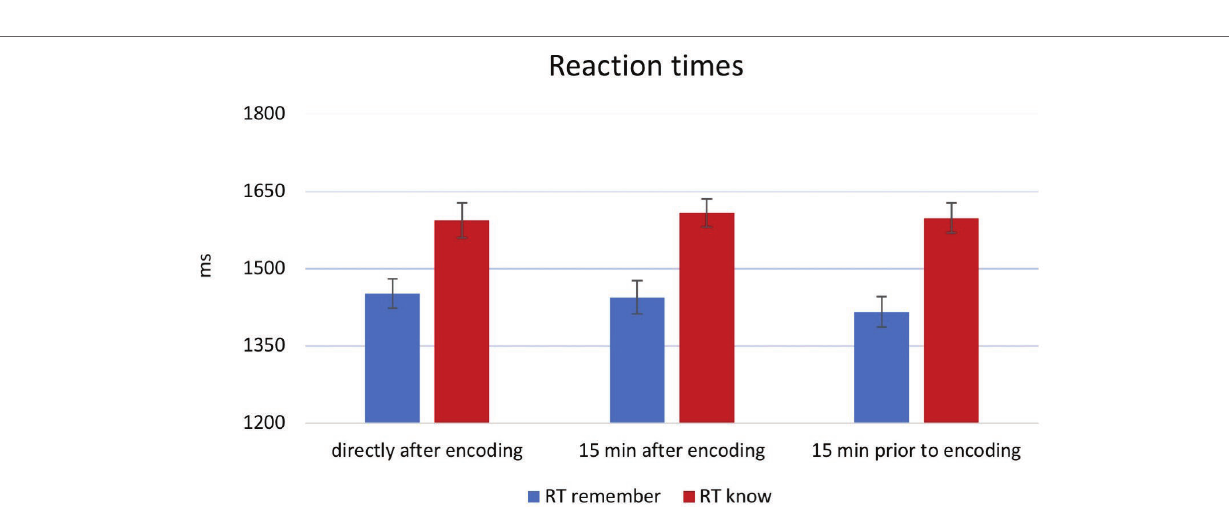
FIGURE 3 | Results for RTs at retrieval. Overall, reaction times (RTs) were faster for “remember” than “know” responses (main effect), but there was no significant effect of novelty. For display purposes, groups were combined. Error bars indicate ±1